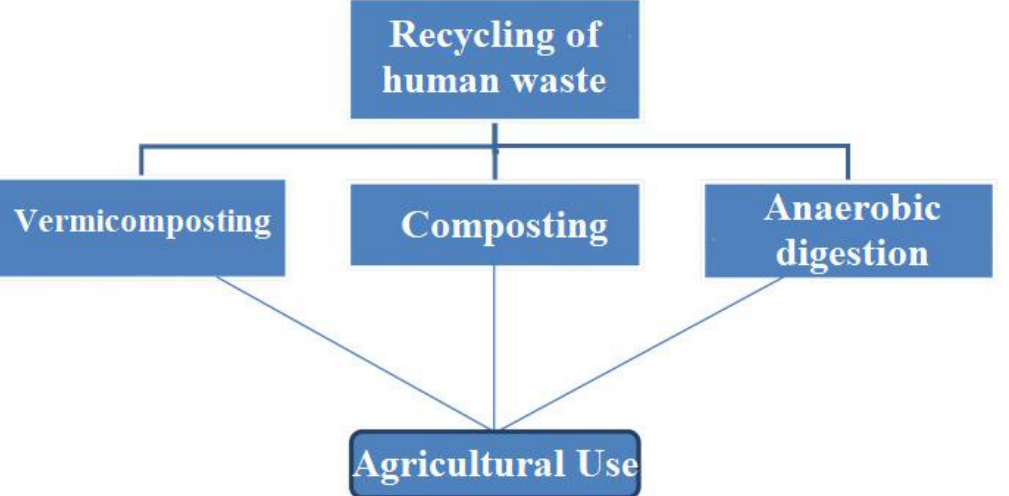
Figure 3. Conventional techniques for human waste treatment.